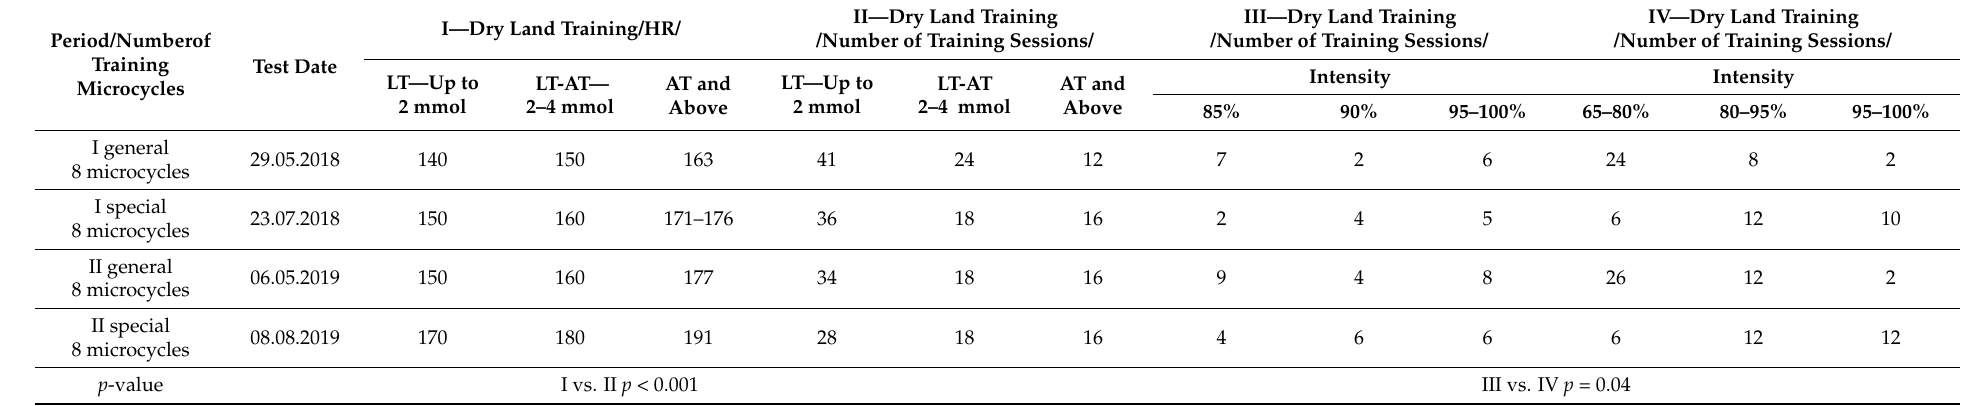
Table 3. Dry land training in individual training periods.